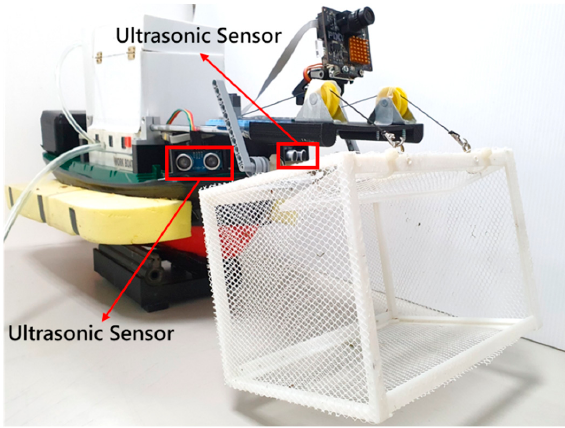
Figure 4. Ultrasonic sensors mounted on the MF-USV.